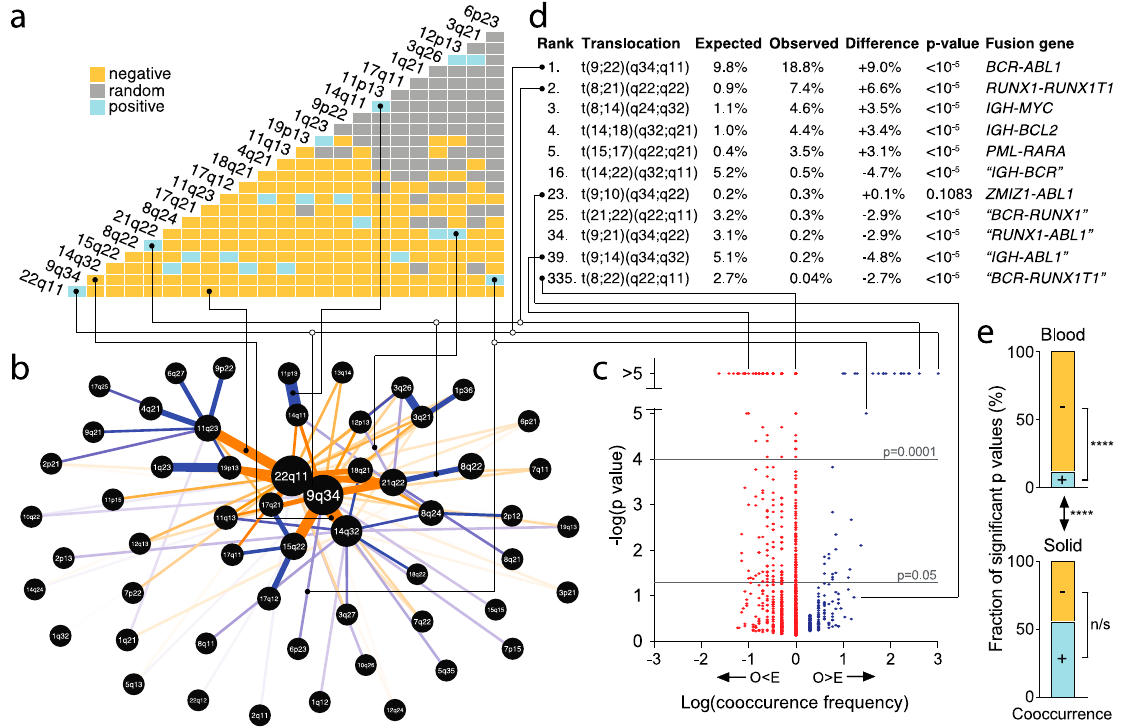
Figure 6. Identification of significantly recurrent and underrepresented translocations. ( a ) Matrix of co-occurring pairs of breakpoints in the indicated cytogenetic chromosome bands, which constitute translocations. For each pair/translocation, p -values were calculated using Veech’s probabilistic model [39]. Statistically significantly ( p < 0.05) more observed than expected (“positive”) translocations—taking into account the frequencies at which each individual cytogenetic chromosome band is involved in translocations—are shown in blue. Translocations occurring at significantly lower than expected frequencies (“negative”) are shown in orange. Non-statistically significant pairs (“random”) are shown in grey. Only part of the matrix is shown. The full matrix is shown in Supplementary Figure S1a. ( b ) Network of translocations in blood cancers per cytogenetic chromosome band (see also Supplementary Figure S1a). Each node represents a cytogenetic band. Node size is proportional to the frequency at which translocation breakpoints occur in the band. Edges represent the specific translocations/co-occurring pairs. Thickness of the edges is inversely proportional to the p -value according to Veech’s probabilistic model. Blue edges indicate statistically significantly more observed than expected translocations. Orange edges indicate significantly lower than expected frequencies. Only the top 100 significant pairs are shown. ( c ) Volcano plot for translocations/co-occurrences. For each translocation, the –log( p -value), according to Veech’s probabilistic model, is plotted against its frequency. Frequencies are shown as negative, if the observed frequency (O) is smaller than the expected frequency (E) and as positive if O > E. See also Figure S2. ( d ) Table of the top five most common and selected other translocations in blood cancers. The full table is shown in Supplementary Table S2. Lines link selected translocations in ( a – d ). ( e ) Distribution of the numbers of statistically significant positive and negative translocations in blood and solid cancers. p -values: Fisher’s exact tests. N/s, not significant; ****, p < 0.0001.